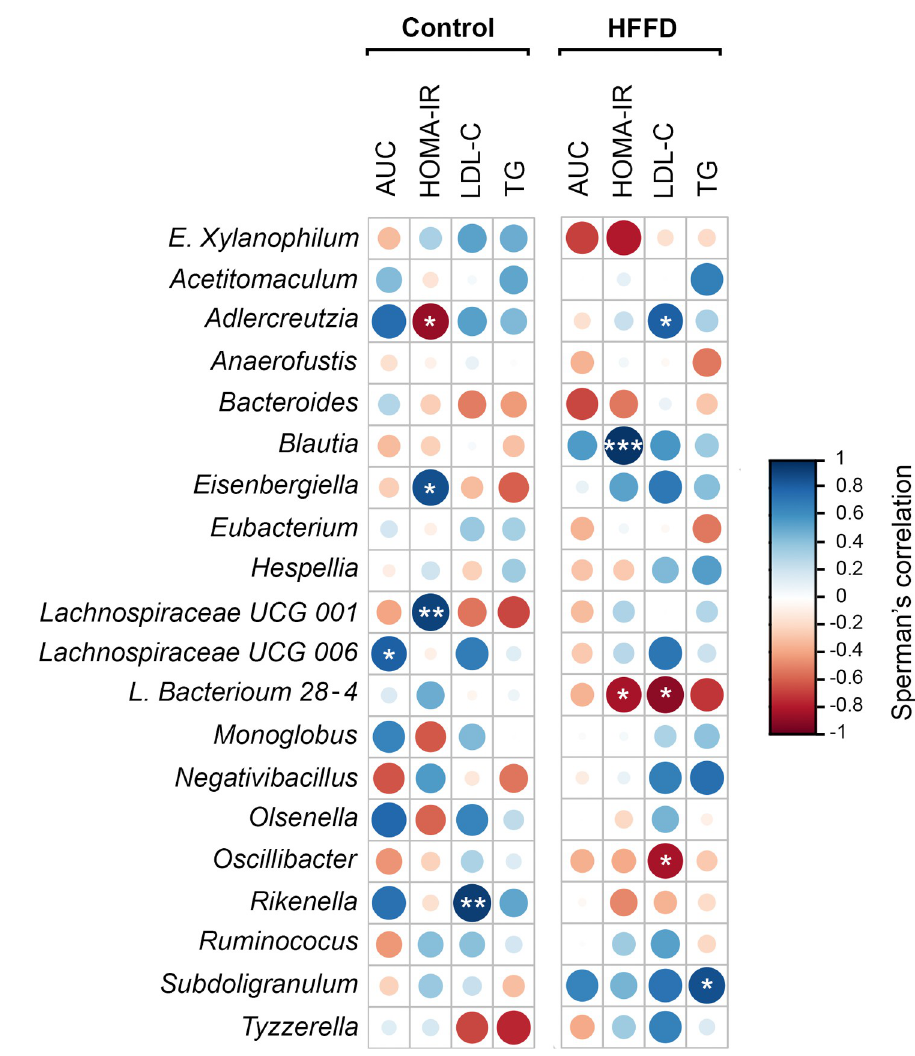
Fig 7. Correlation heatmap representing correlation coefficients between changes in bacterial abundance (at the genus level) and the host’s parameters (AUC GTT , HOMA-IR, LDL-C and TG). Associations were performed in R based on Spearman’s correlation. The corrplot and Hmisc package were used to produce the correlation matrix. Positive correlations are displayed in blue and negative correlations in red color. Color intensity and the size of the circle are proportional to the correlation coefficients. Correlation results were considered statistically significant at p value. � FDR < 0.05, �� FDR < 0.01 and ��� FDR < 0.001 (n = 7 for Control and n = 7 for HFFD). AUC, HOMA-IR, LDL-C and TG denote area under the curve, homeostasis model assessment of insulin resistance, low density lipoprotein cholesterol and triglyceride,